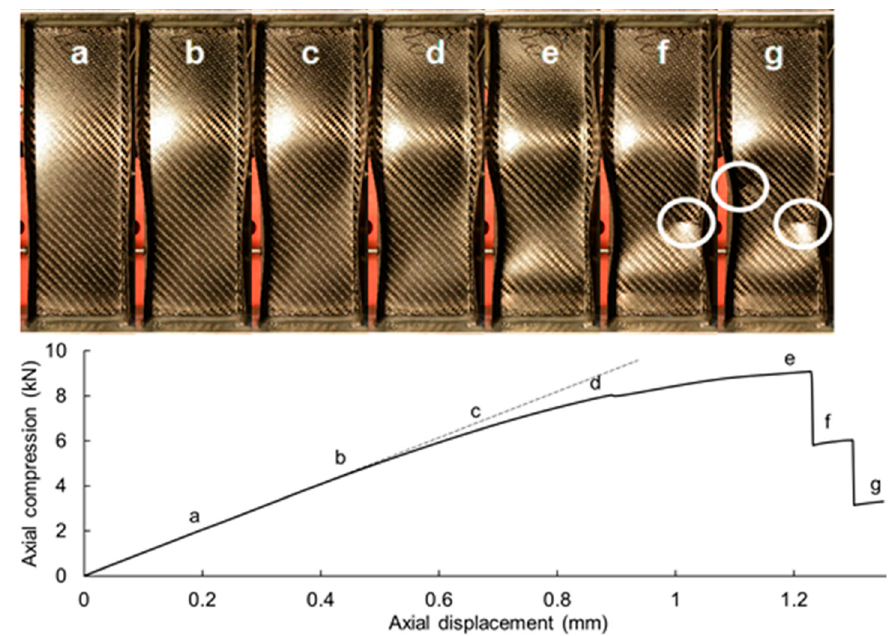
Figure 3. Exemplar carbon fiber composite channel (960 gsm) compression test (dashed line indicates the channel compression stiffness; circles indicate fractures; all column heights are 300 mm).